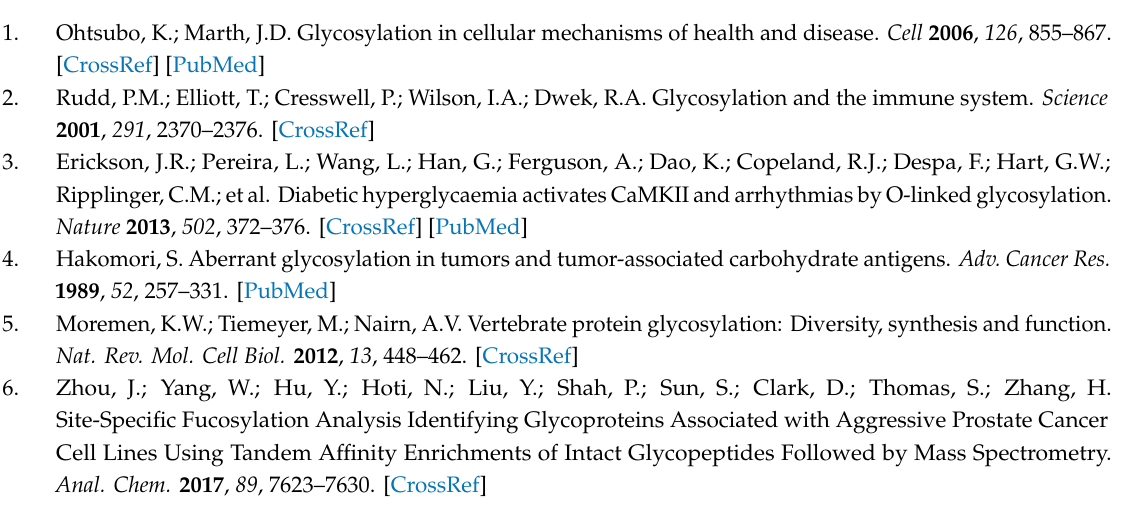
Figure S1: Gross analysis of the LC-MS spectra., Table S1: Deglycosylated peptides identified by MaxQuant from the NGAG protocol, Table S2: Deglycosylated peptides identified by MaxQuant from the HILIC protocol, Table S3: Deglycosylated peptides identified by MaxQuant from the SPEG protocol, Table S4: Intact glycopeptides identified by GPQuest from the NGAG protocol, Table S5: Glycans released by PNGase F from NGAG-immobilized glycopeptides identified by MALDI-TOF analysis and GlycoPeakFinder online